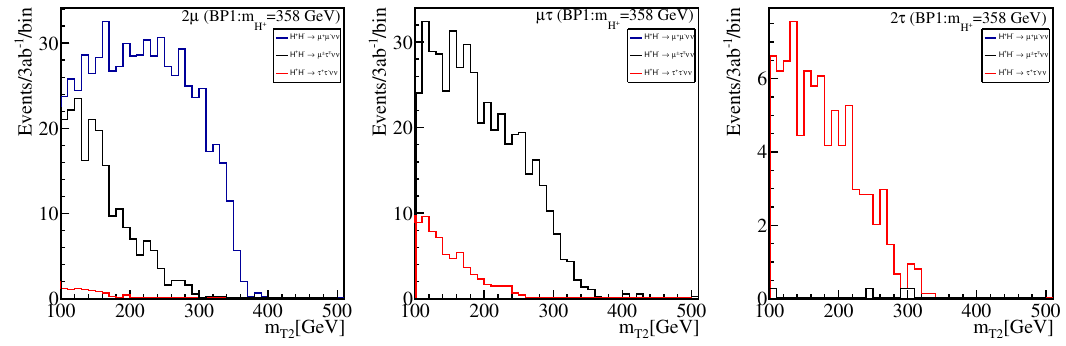
Figure 7 . The m T 2 distribution for BP1 in the 2 (cid:22) (left), (cid:22)(cid:28) (center), and 2 (cid:28) (right) modes are